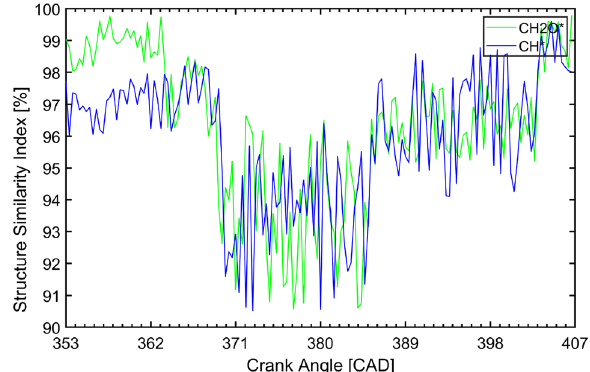
Figure 8. The structure similarity index of the CH 2 O* and CH* between the raw image and reconstructed image.